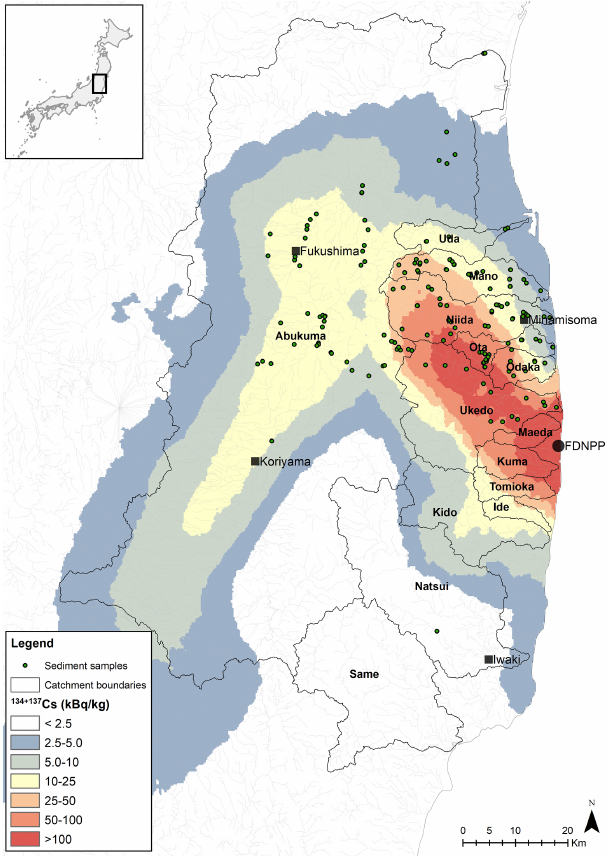
Figure 1. Location of the sediment samples collected between 2011–2020 in the river catchments draining the main radioactive plume near the FDNPP. Background map of initial radiocesium con- centrations after Chartin et al.